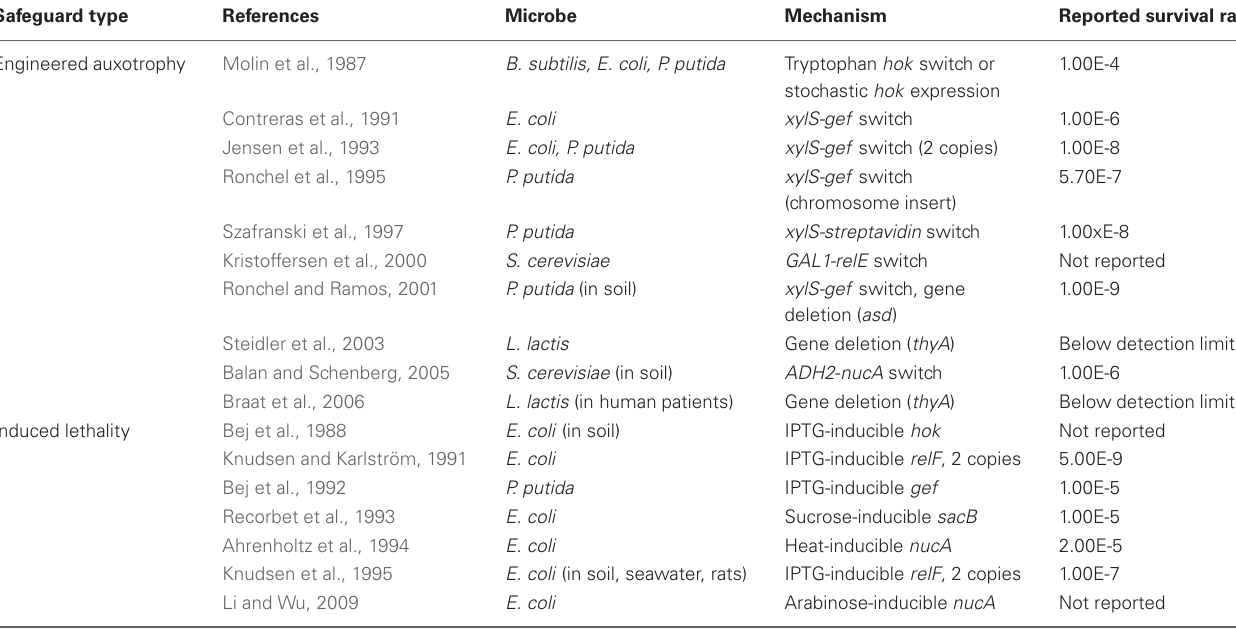
Table 1 | Lowest reported frequencies of microbes that escape engineered auxotrophy and induced lethality safeguard systems.